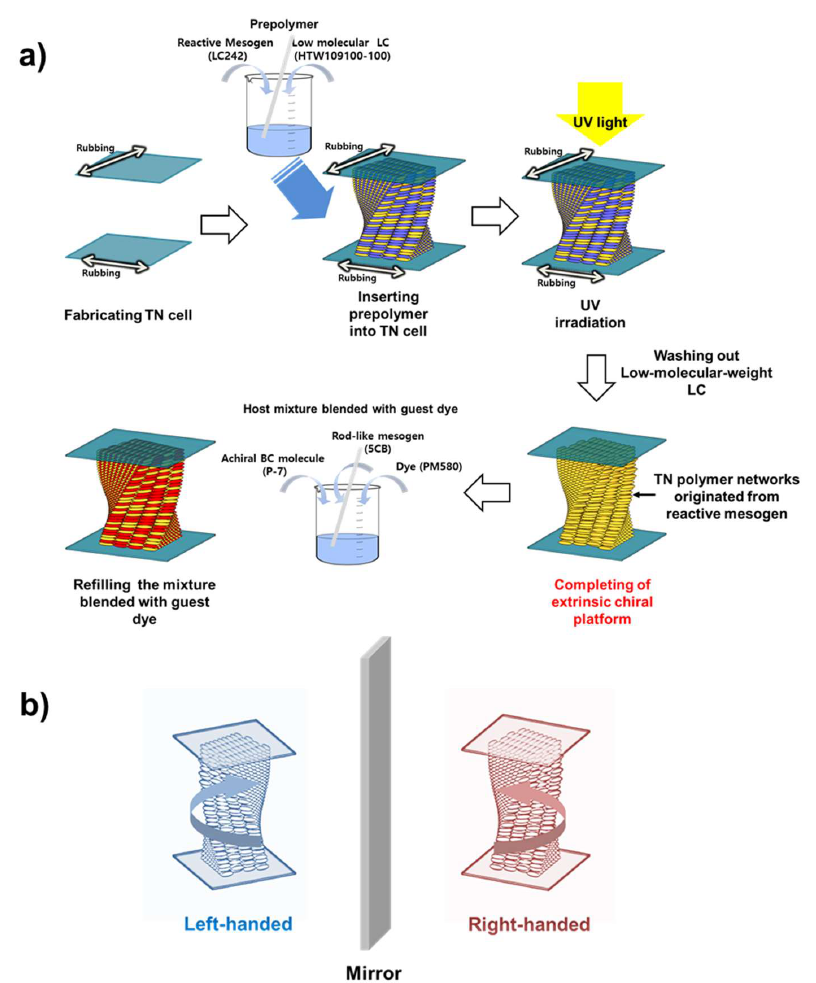
Figure1. ( a )Fabricationoftheextrinsicchiralplatform. ( b )Thepairoftwistednematic(TN)orientations. Polymers 2020 , 12 , x FOR PEER REVIEW Figure 1. ( a ) Fabrication of the extrinsic chiral platform. ( b ) The pair of twisted nematic (TN) orientations.